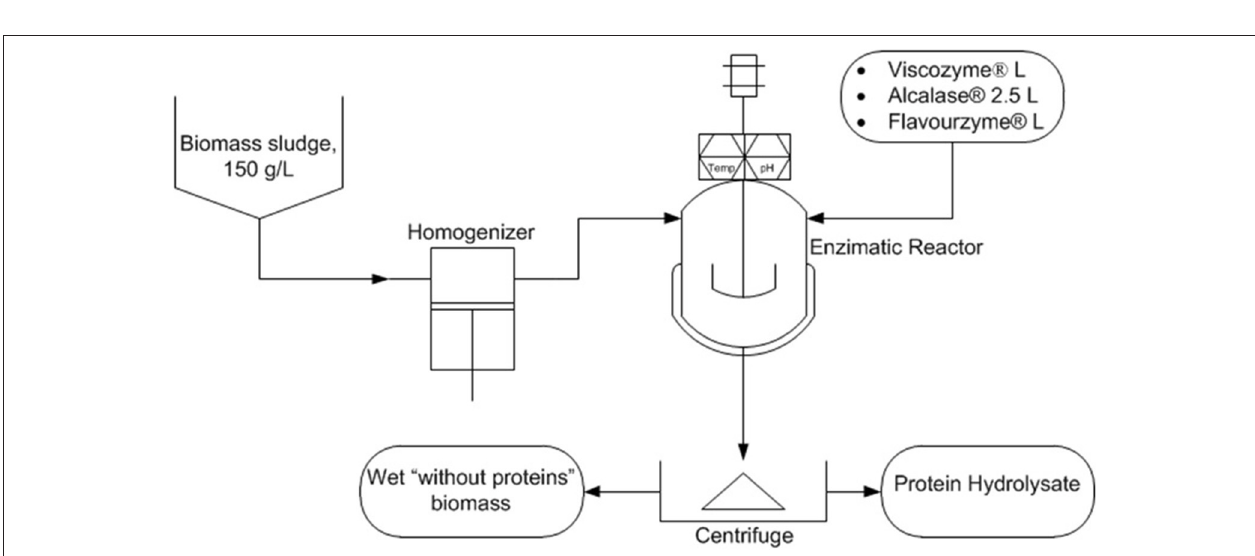
FIGURE 6 | Scheme of the enzymatic hydrolysis process for the production of amino acids concentrates from microalgae biomass produced by recovering nutrients from wastewater.